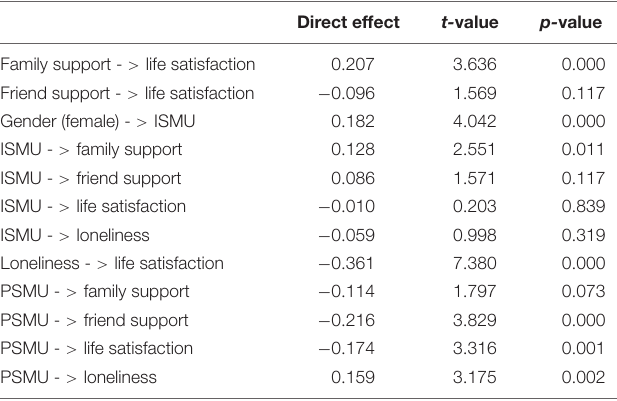
TABLE 1 | Significance analysis of the direct